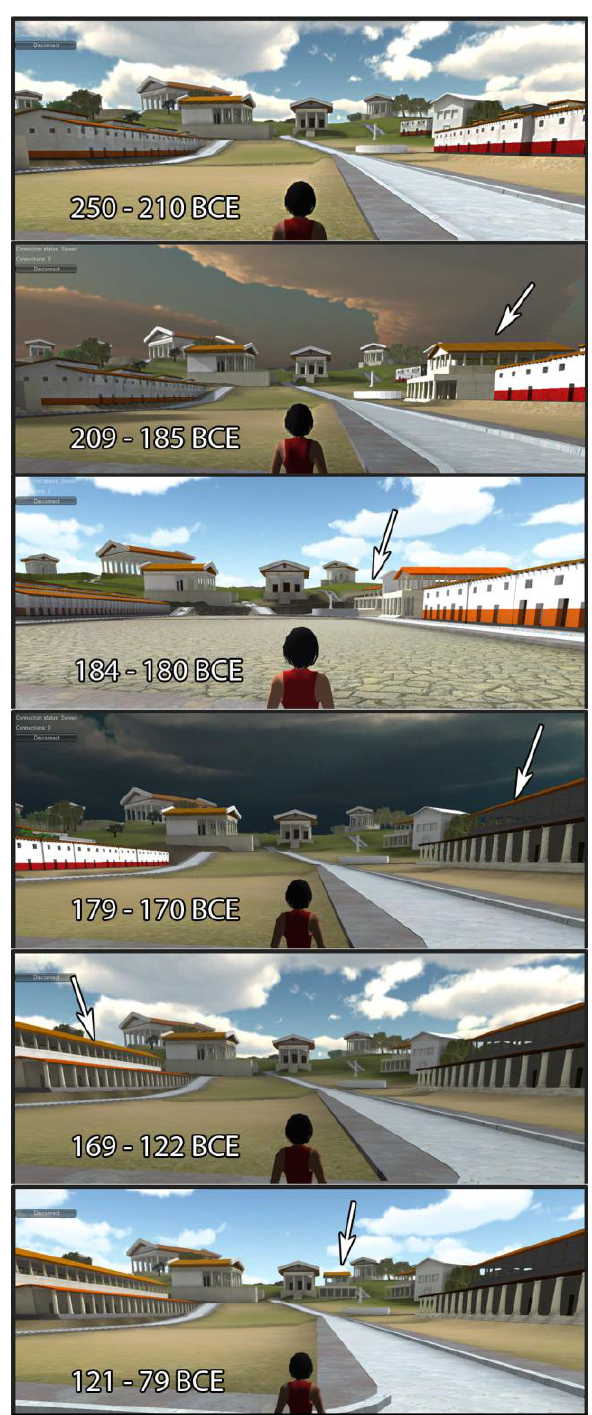
Figure 7. Building phases in the Roman Forum. Arrows indicate the newly constructed basilicas for each